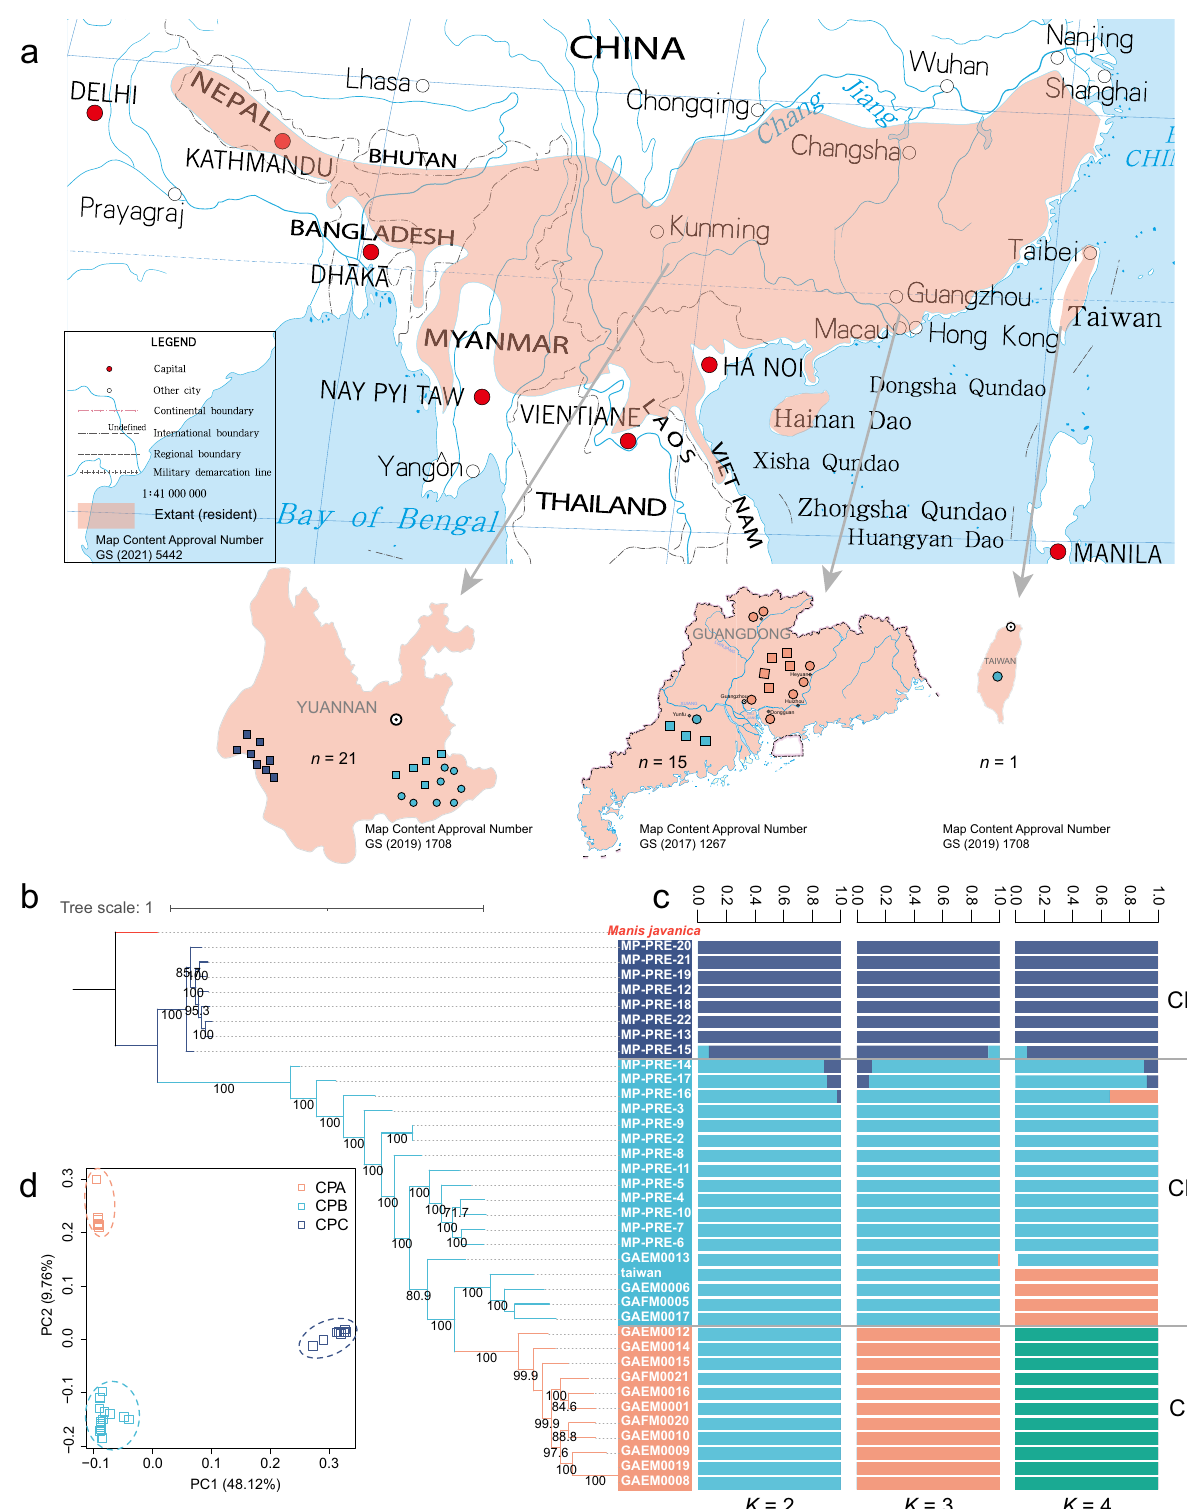
Fig. 1 Distribution and population structure of Chinese pangolins in southern China. a Distribution of extant Chinese pangolins and 37 individuals in the current study. The distribution range of extant Chinese pangolins was from IUCN 29 . Pink regions represent areas where Chinese pangolins have been recorded. Circles represent samples with known origins. Squares represent the samples of unknown geographical information. CPA ( n = 11), CPB ( n = 18) and CPC ( n = 8) was in orange, blue and purple, respectively. b Maximum likelihood phylogenetic tree of Chinese pangolin populations. Numbers at tree nodes represented the bootstrap supports (1000 replications). The Malayan pangolin, CPA, CPB and CPC are in red, orange, blue and purple, respectively. c Population structure inferred using ADMIXTURE analysis from K = 2 to K = 4. Clusters were noted by different colors, and each bar represented an individual. d Principal component analysis of all 37